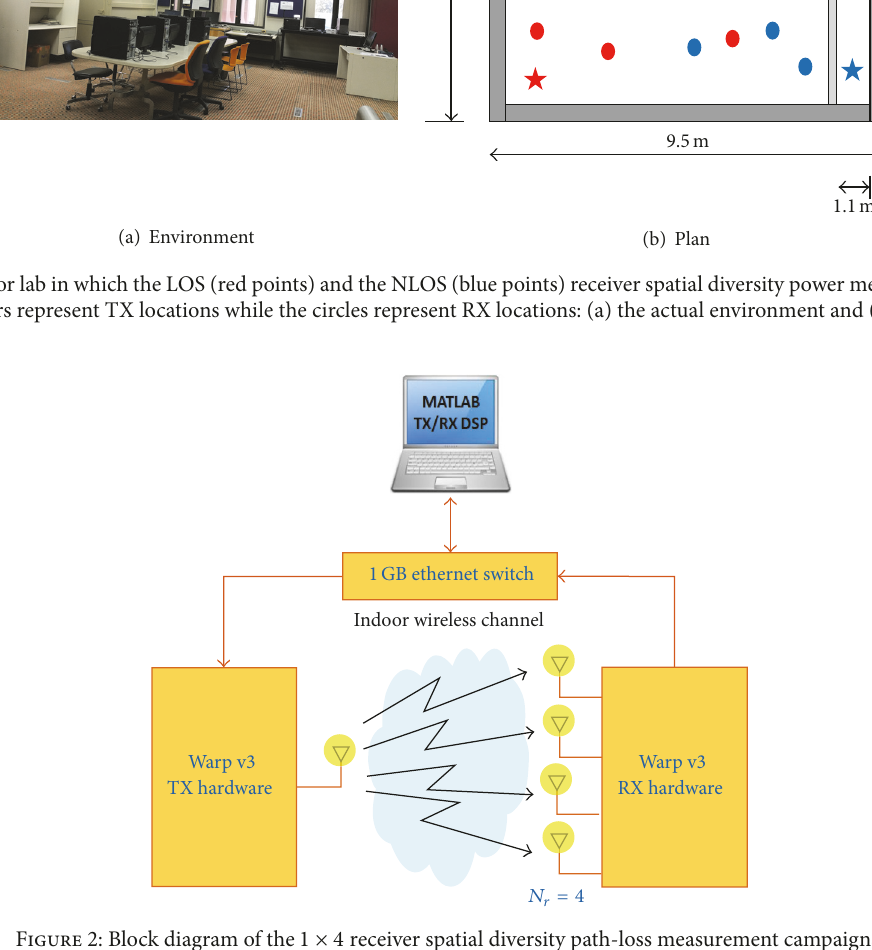
Figure 2: Block diagram of the 1 × 4 receiver spatial diversity path-loss measurement